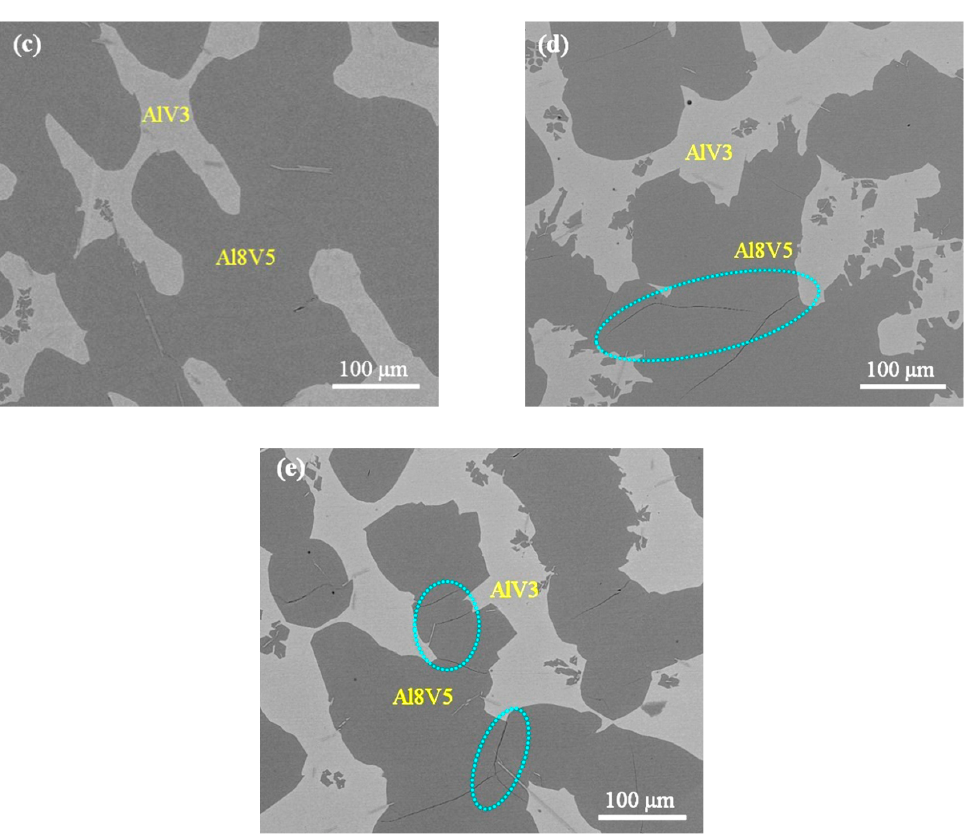
Figure 5. SEM images of AlV produced by different proportion of raw materials ( a ): M Al : M V2O5 = 0.9:1; ( b ): M Al : M V2O5 = 0.92:1; ( c ): M Al : M V2O5 = 0.94:1; ( d ): M Al : M V2O5 = 0.96:1; ( e ): M Al : M V2O5 = 1.0:1.